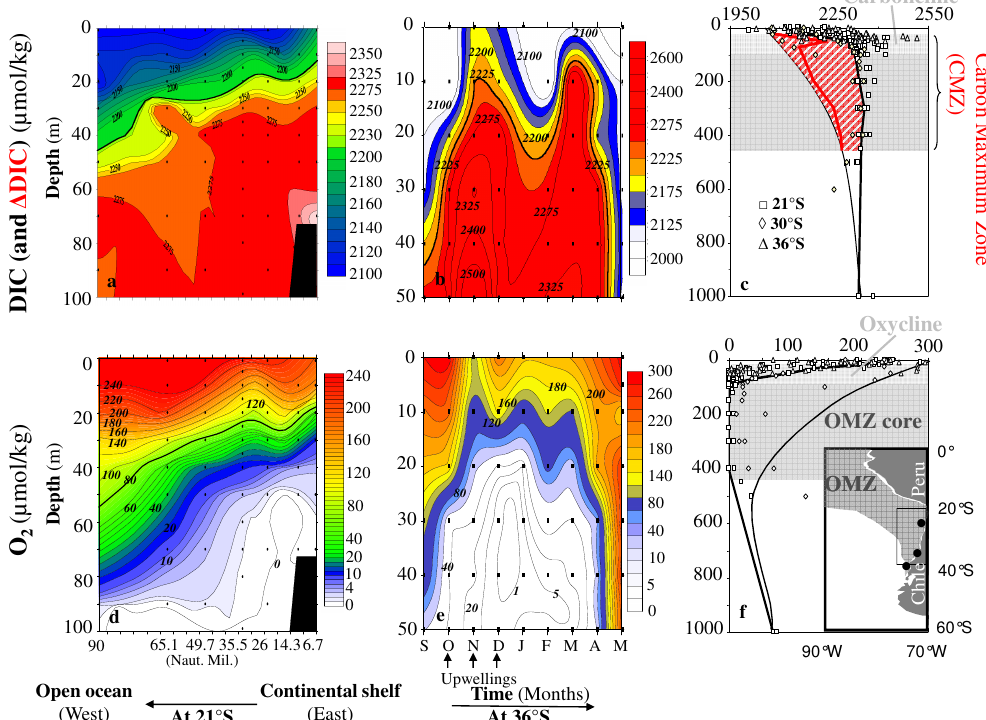
Fig. 1. Vertical sections along an east-west cross-shore transect on 0–100m (DIC: (a) ; O 2 : (d) and versus time on 0–50m (DIC: (b) ; O 2 : (e) . Points indicate sampling locations. Profiles of DIC (c) and O 2 (f) on 0–1000m for all stations sampled in the OMZ off Chile in 2000– 2002. Continuous thin profiles correspond to classical profiles out of the OMZ in the Eastern Equatorial Pacific (for DIC on (c) : Viecelli, 1984; for O 2 on (f) : Ivanoff, 1972). Continuous thick black profiles indicate representative profiles for DIC on (c) and for O 2 on (f) . On c and f , data from Iquique at 21 ◦ S (squares), Coquimbo at 30 ◦ S (diamonds) and Concepci´on at 36 ◦ S (triangles). On (c) : the hatched red area indicates DIC CMZ (DIC CMZ = DIC Average on OMZ – DIC Classical out of OMZ ) corresponding to the carbon maximum zone (CMZ); continuous thick red profile indicates the representative profile for the sum of DIC Classical out of OMZ and local DIC production contributing to the CMZ (DIC Classical out of OMZ + 1 DIC), with 1 DIC the biogeochemical contribution to DIC. The points on the map in (f) indicate the three sampled latitudes (21 ◦ S; 30 ◦ S; 36 ◦